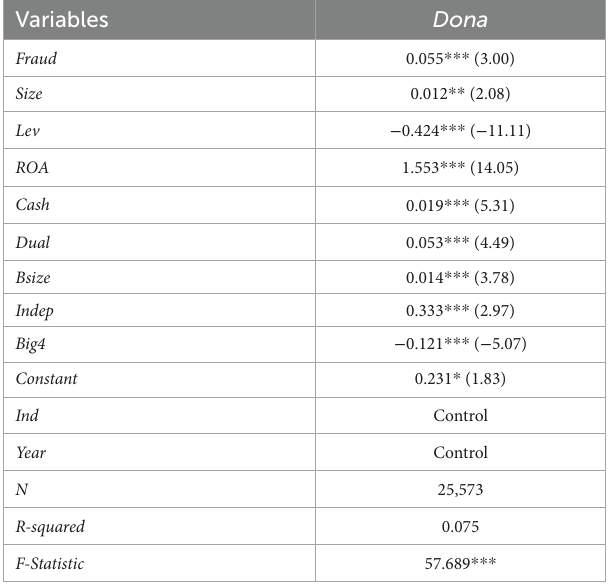
TABLE 4 Corporate violation and charitable donation: benchmark regression results.